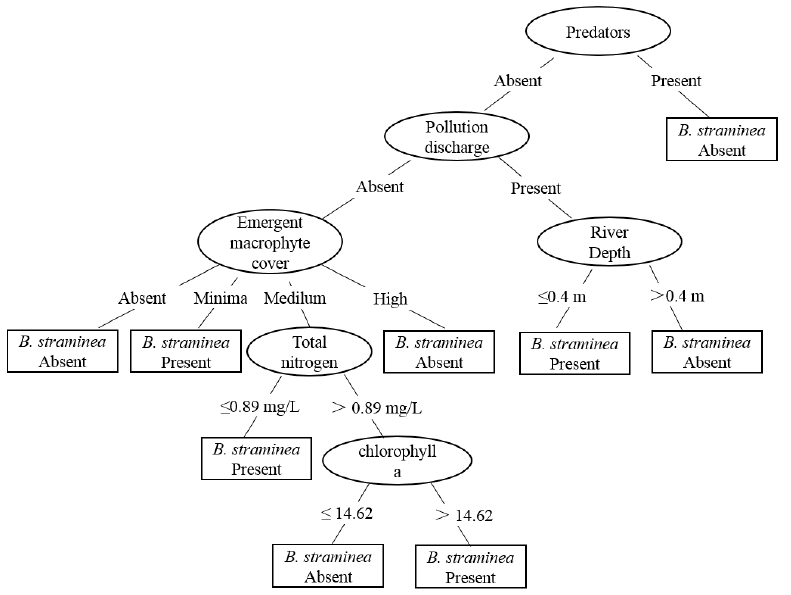
Figure 3. Classification tree model predicting the presence or absence of Biomphalaria straminea.